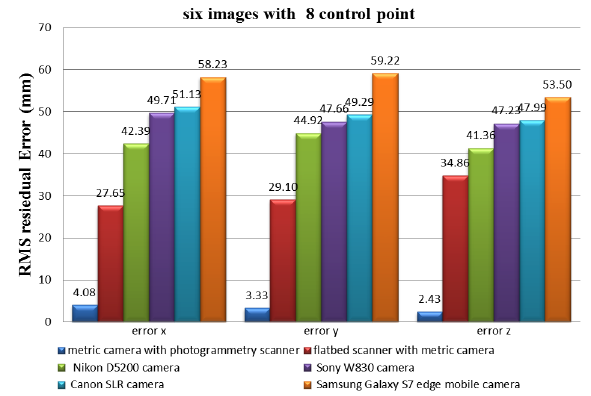
Figure 13. RMS residual errors in CRP technique for all types of cameras using six images and eight control